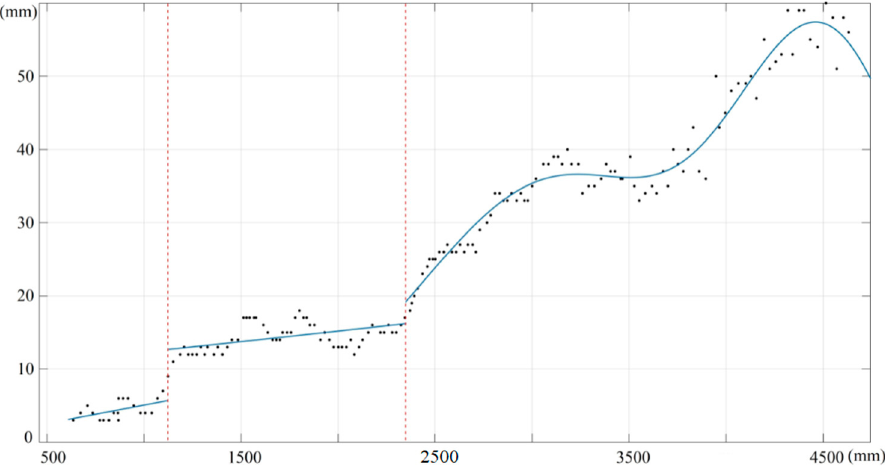
Figure 7. Fitting curve of the depth error at different ranges of depth.